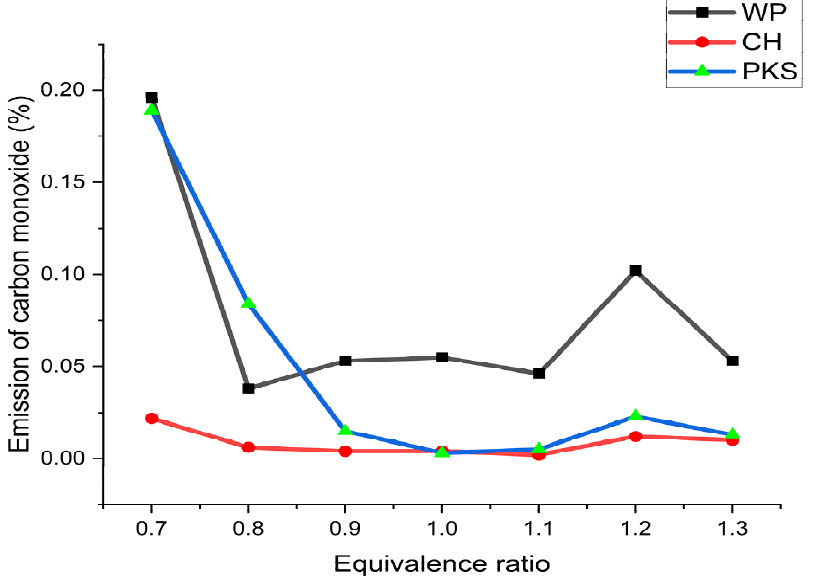
Figure 10. Emissions of carbon monoxide of 3 BPG at 𝜙 from 0.7 to 1.3.